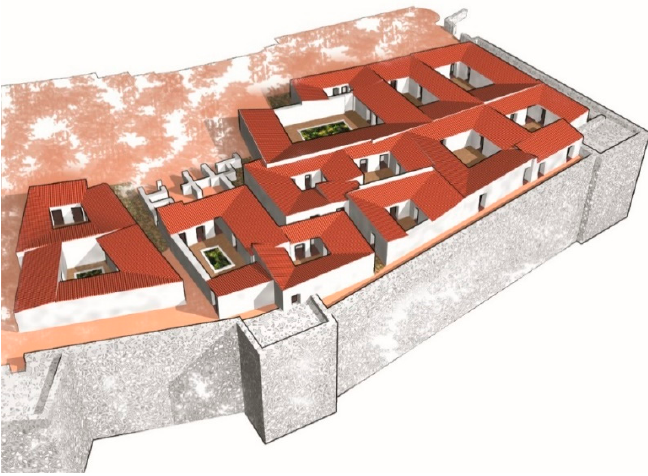
Figure 4. Mértola—Islamic quarter reconstitution. Reconstitution by the author.